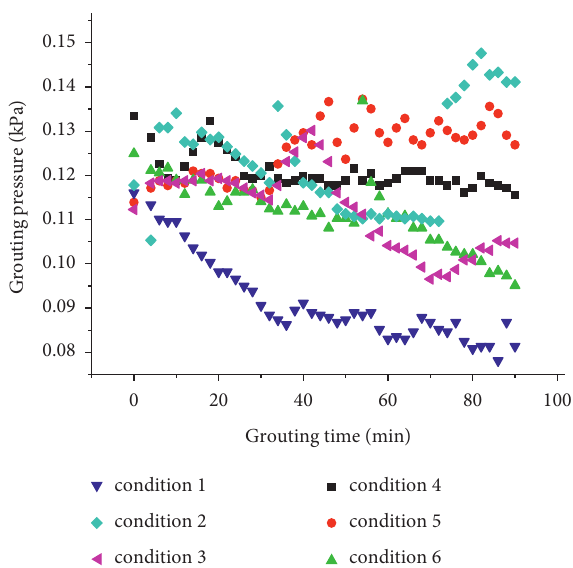
Figure 12: Case A1’s grouting pressure changes with time in the jacking return times.